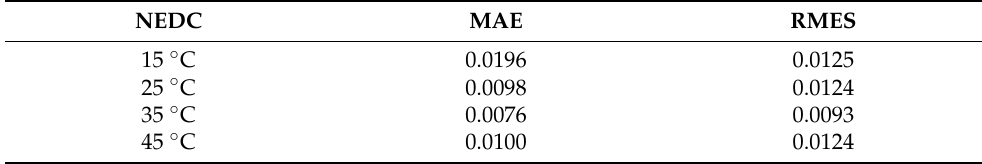
Figure 10. Bus route map.